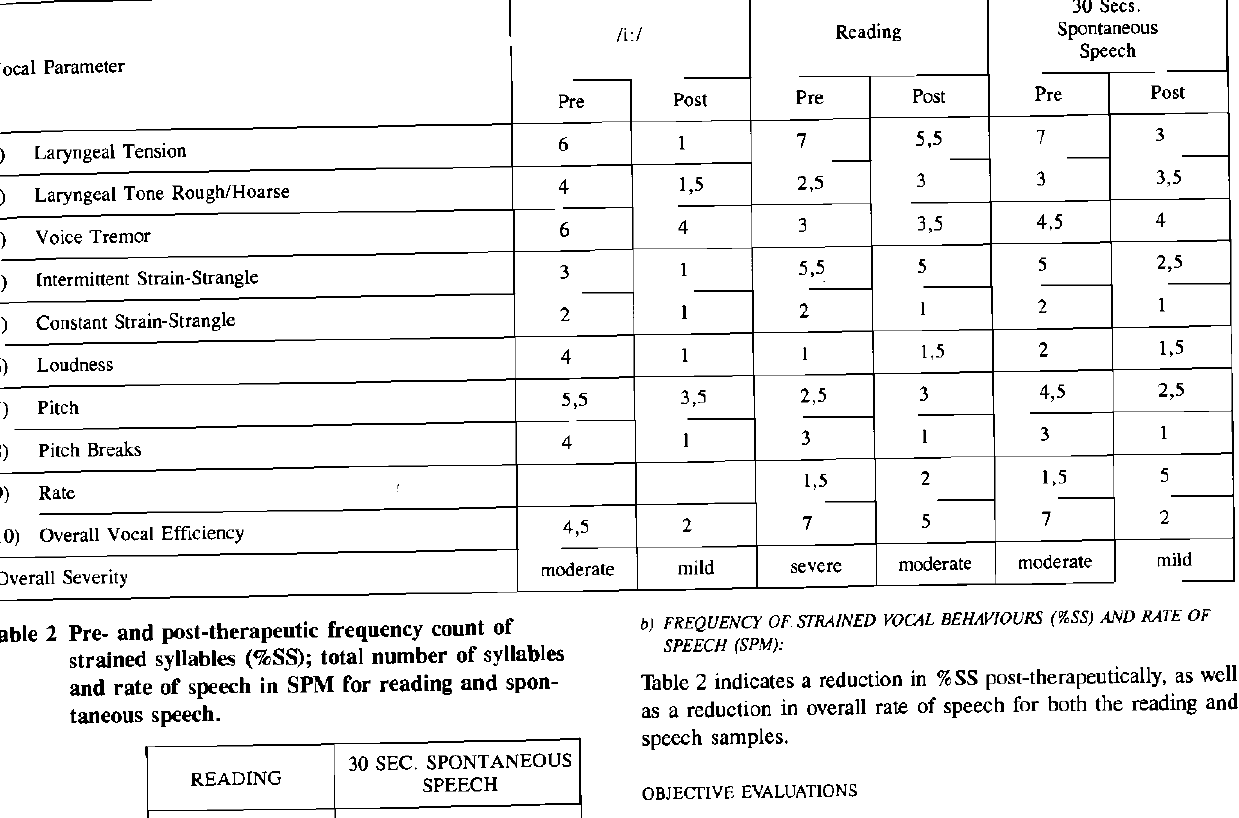
Table 2 indicates a reduction in %SS post-therapeutically, as well as a reduction in overall rate of speech for both the reading and speech samples.